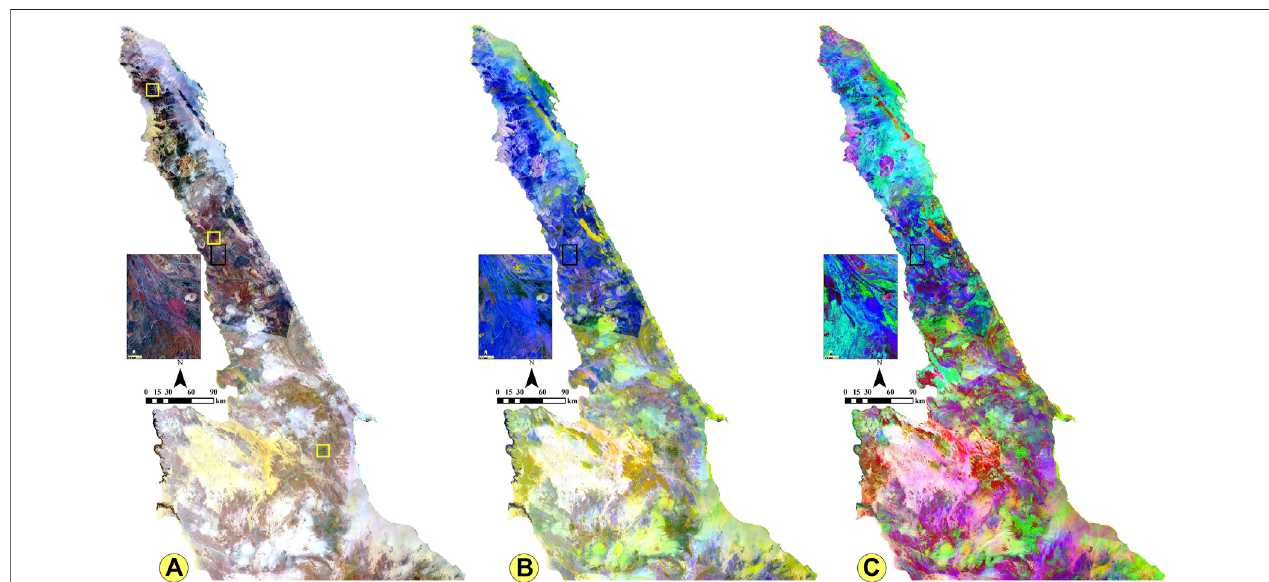
FIGURE 4 | Lithological discrimination using Landsat-8 OLI. (A) false color composite FCC RGB-753 discriminates ophiolitic association and related rocks and Hammamatsedimentswithverydarkbluepixelsandthesyntolateandpost-tectonicgranitoidswithlighttodarkbrownpixels. (B) PrincipalcomponentanalysisinPCA RGB (PC2, PC1, PC4) highlights the metavolcanics – metasediments association and clearly displays the sense of shearing and dislocation. (C) PCA RGB (PC2, PC3, PC4)promotestheophioliticrockswithbrightgreensignature,metavolcanicswithbluetovioletpixels,Hammamatsedimentswithcyancolorandclearlyenhances the foliation, major thrusts, and strike-slip movement. The inset image (outlined in black on the main maps) is an enlarged area for more details. The yellow boxes show the geographic locations of the tested area in the ( Supplementary Figures 1A – C ) from north to south, respectively.